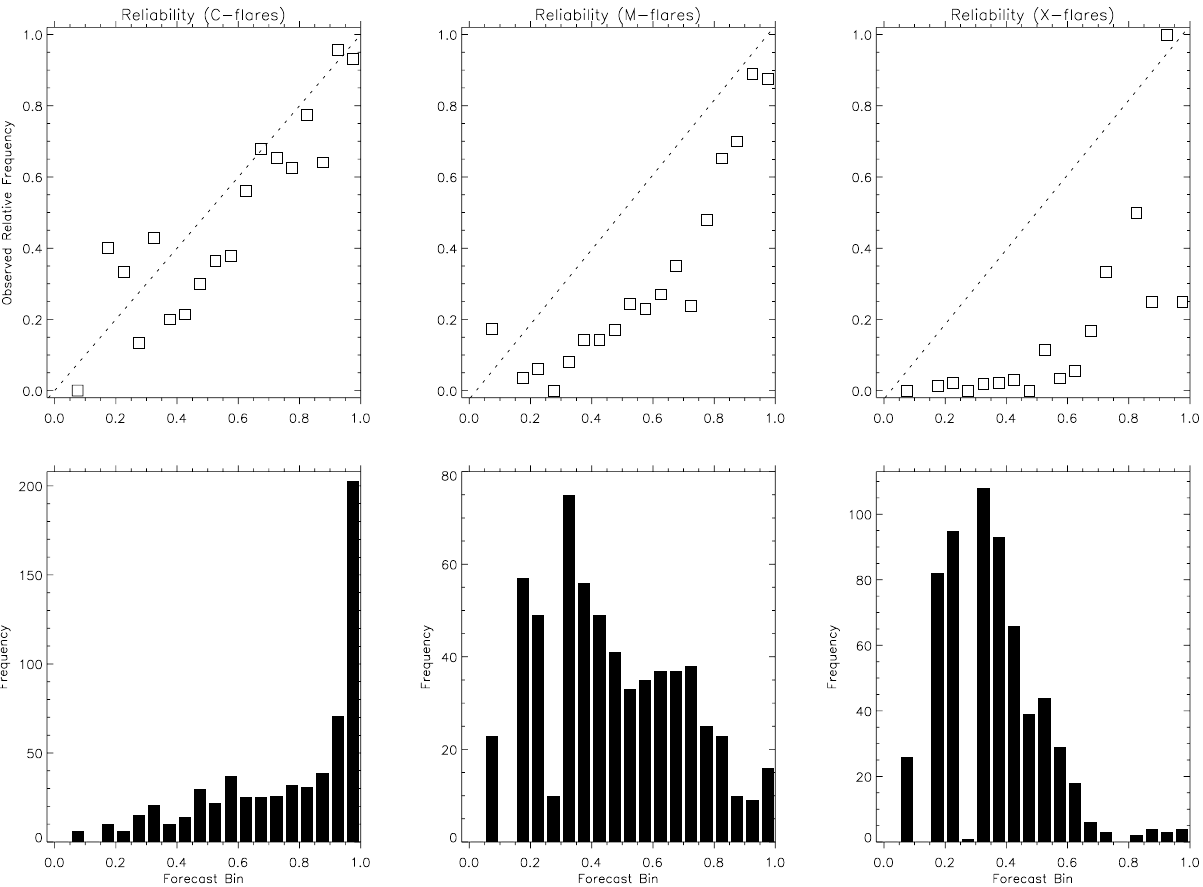
Fig. 11. Reliability of flare forecasts. The top panel plots the observed relative frequency of C, M or X flare days against their corresponding forecasts, grouped in 5% bins. The red dashed line represents the perfect correspondence. Points below this diagonal indicate an overestima- tion, points above the diagonal indicate an underestimation. The lower panel shows the number of the forecasts in each bin. The data covers the period from April 2003 until